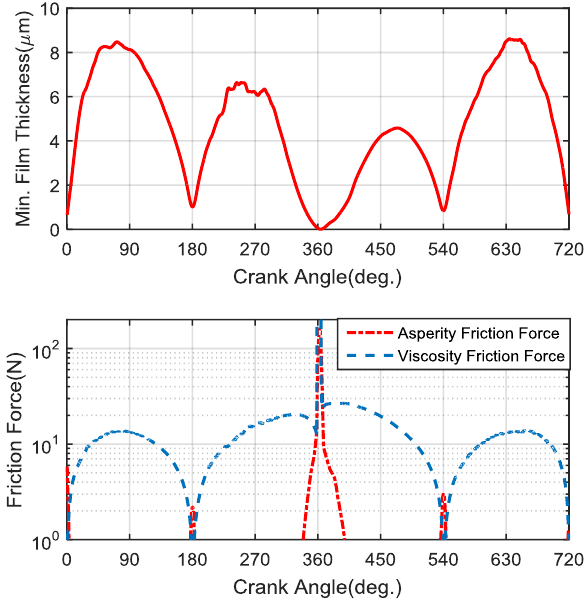
Figure 9. Minimum oil film thickness and friction force predicted based on conventional model without considering deformations.